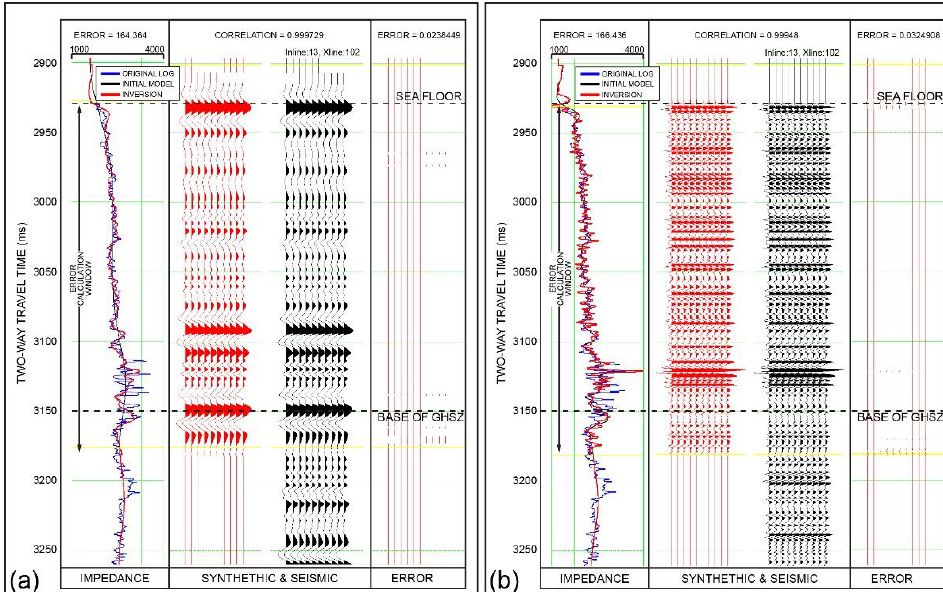
Figure 6. ( a ) C3DS and ( b ) H3DS seismic inversion results at the UBGH2-6 well. The left panel in each figure shows three curves: initial model impedance (black), original log (blue), inversion result (red). The middle panel in each figure shows synthetic (red) and actual seismic (black) traces. The right panel in each figure shows the error traces (difference between synthetic and real seismic traces). The inversion results match well with the derived impedance from the well-log. The cross-correlation ratio between synthetic and seismic traces is 0.99948 for ( a ) and 0.999729 for ( b ). Figure 7e,f show inline 13 and crossline 102 crossing the UBGH2-6 well for the H3DS inversion result. The H3DS inversion result shows that the thin GH-containing sediment layers found at 110–155 mbsf (3100–3150 ms in two-way travel time), which were not recognized by the C3DS inversion, were further subdivided.